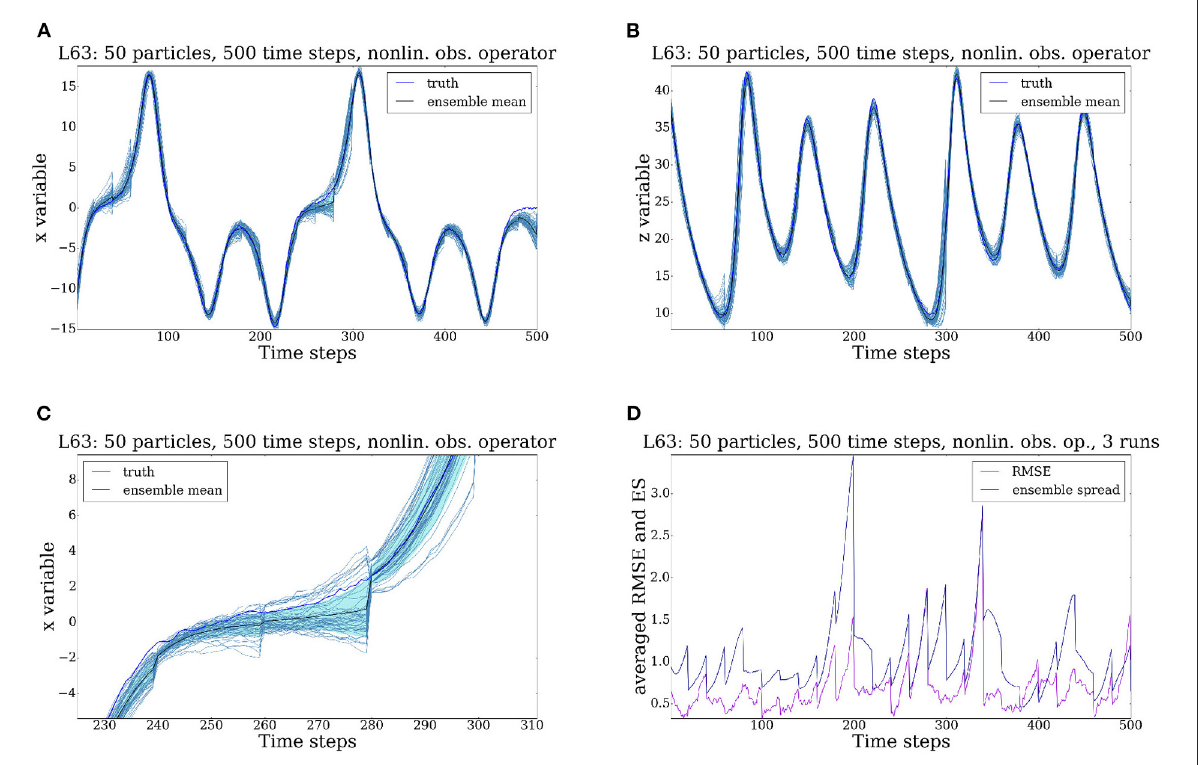
FIGURE8 Evolution of the Lorenz ’63 model for 500 time steps, all 3 variables are observed every 20 time steps. Observations are denoted by z 1 , z 2 , z 3 . Partially nonlinear observation operator i.e., z 1